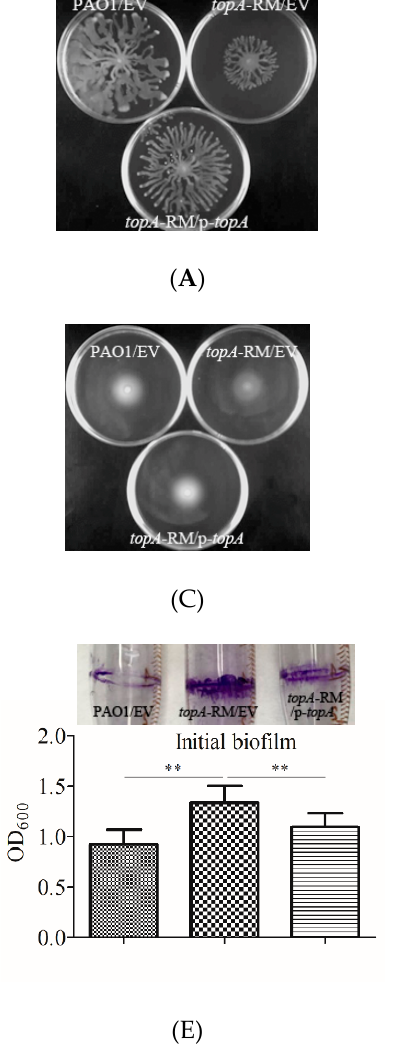
Figure 5. Changed motility and initial biofilm formation in topA -RM. ( A ) Effect of altered TopA on swarming, ( B ) quantification of swarming motility by the diameters of the covered areas, ( C ) swimming, and ( D ) twitching motility. Overnight cultures were spotted onto corresponding plates (2 µ L aliquots) and the plates were incubated at 37 °C. The images were captured using a LAS-3000 imager. ( E ) A photo of the biofilms binding to the tubes and quantification of the biofilms by crystal violet staining. The biofilms were analyzed after 16 h growth. The two-tailed unpaired t-test was carried out using GraphPad software ( ** P < 0.005 compared to WT or complemented strains). EV: Empty vector control. p- topA : topA complementation construct.